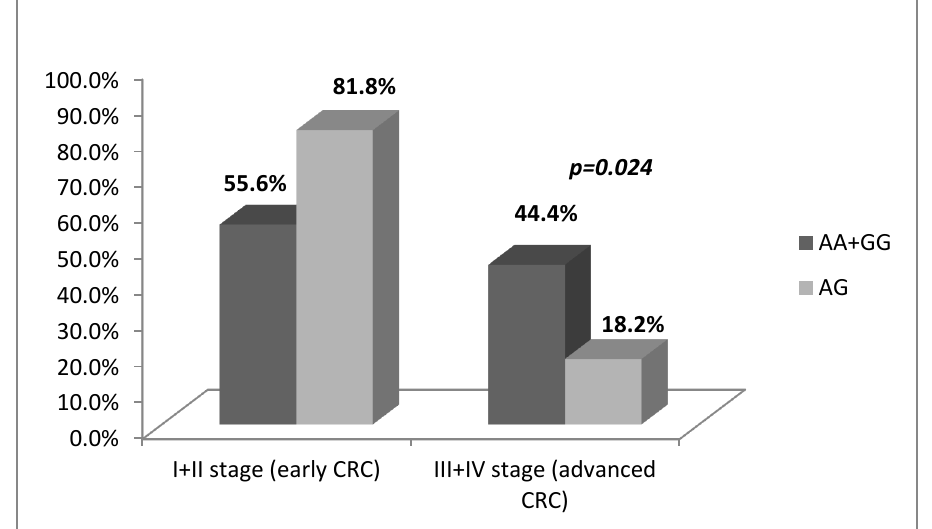
Figure 4 . IL17A -197A/G genotype associations according to CRC stage. The heterozygous genotype was significantly less frequent in advanced CRC stage.